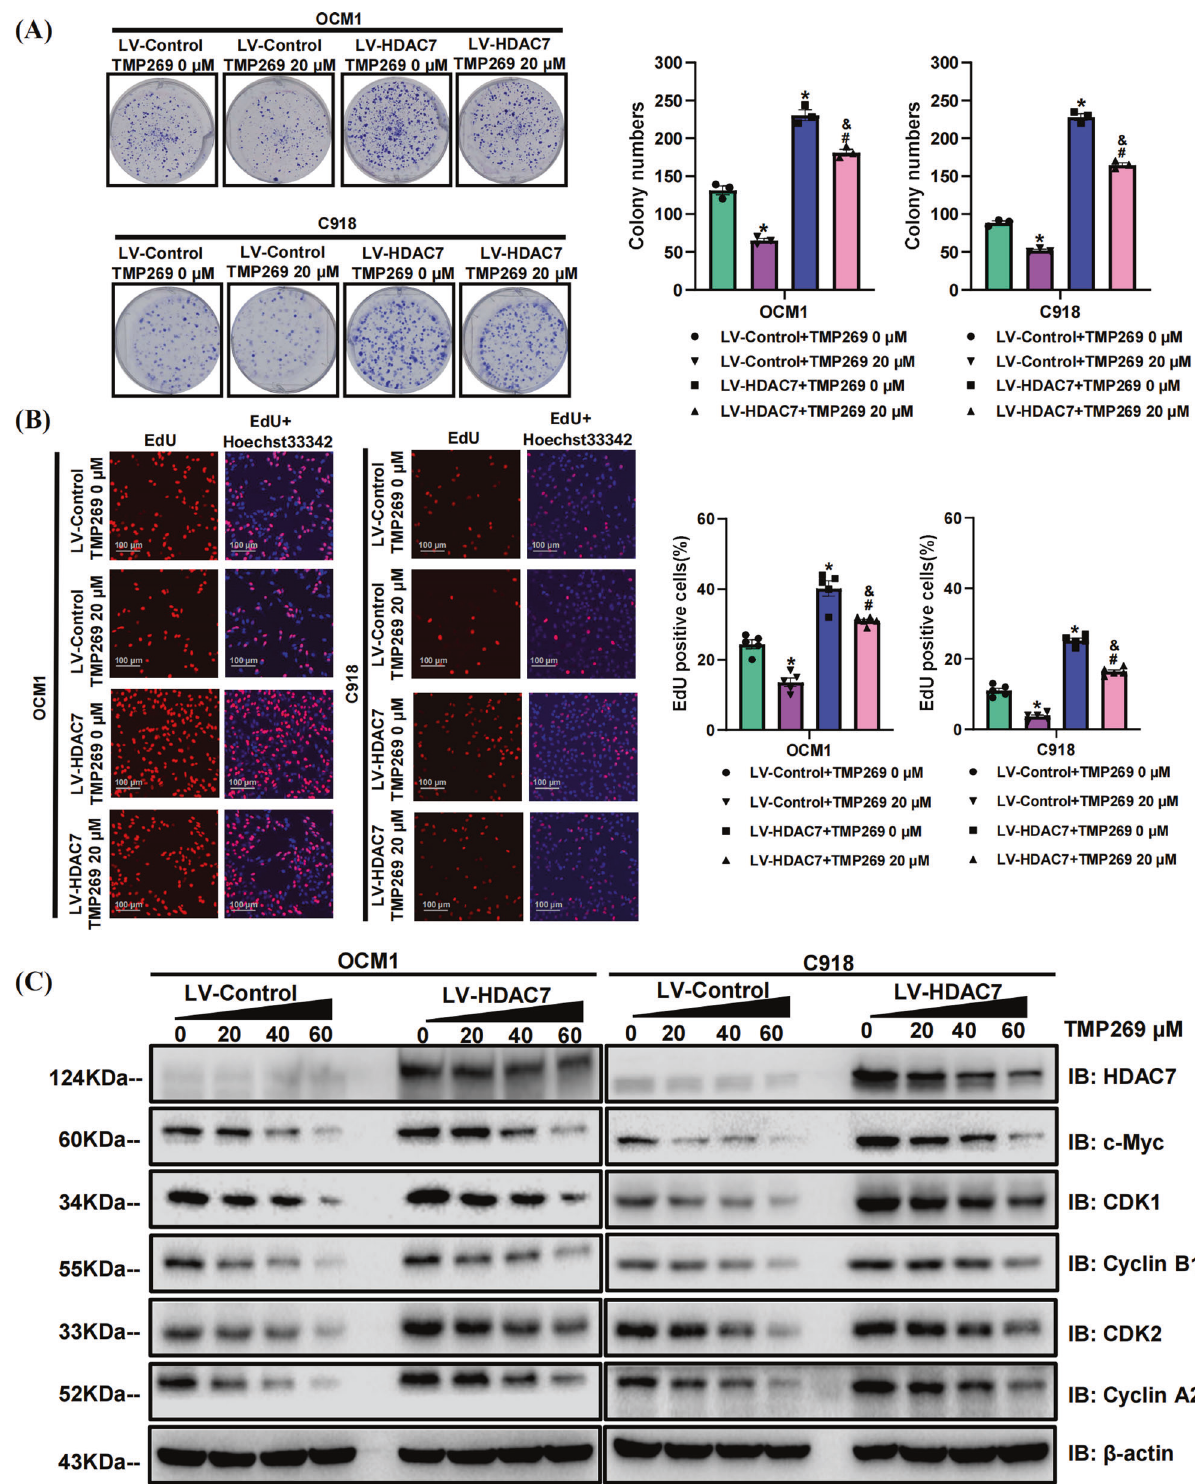
Fig. 3 TMP269 suppresses HDAC7-mediated OCM1 and C918 cell proliferation. LV-Control and LV-HDAC7 OCM1/C918 cells were pretreated using TMP269 for 48 h. A Typical pictures and statistical analysis of the colony formation assay. B Typical pictures and statistical analysis of the EdU incorporation assay in LV-HDAC7 OCM1/C918 and LV-Control OCM1/C918 cells. The results were calculated as the ratio of the number of EdU-positive cells (red fl uorescence) to the total number of Hoechst 33342 stained cells (blue fl uorescence). Scale bar, 100 μ m (inset). C Typical Western blot results of HDAC7, c-Myc, CDK1, Cyclin B1, CDK2, and Cyclin A2 in LV-HDAC7 OCM1/C918 and LV-Control OCM1/C918 cells. β -actin was used as an internal control. Data are exhibited as the mean ± SD. Student ’ s t test, * P < 0.05 vs. the LV-Control + TMP269 0 μ M group; # P < 0.05 vs. the LV-Control + TMP269 20 μ M group; & P < 0.05 vs. the LV-HDAC7 + TMP269 0 μ M group. Abbreviations: LV lentivirus, HDAC7 histone deacetylase 7.